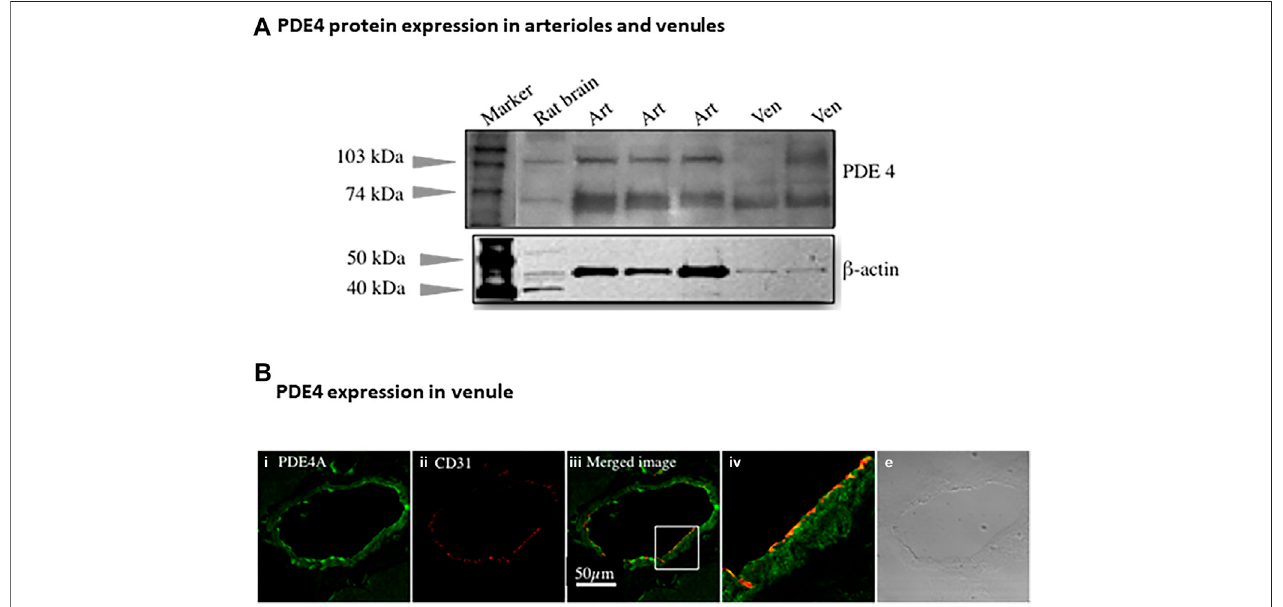
FIGURE 2 | PDE4 protein expression in skeletal muscles arterioles and venules. (A) The representative immunoblotting using non-selective PDE4 antibody shows PDE4proteinexpressedinarteriolesandvenulesisolatedfromratabdominalskeletalmuscles.Ratbrainwasusedasapositivecontrol.Theexpressionof β -actinprotein was used as a loading control for corresponding vessels. Art: arteriole; Ven: venule. (B) The representative immuno fl uorescence imaging was acquired using scanning confocalmicroscopy.ThesectionedratabdominalskeletalmusclewasstainedwithPDE4AprimaryandAlexa-488(greencolor)secondaryantibodies (i) aswellas CD31 (an endothelial marker) primary and Alexa-568 (red color) secondary antibody (ii) . The images of (i) and (ii) were superimposed (iii) , in which the yellow color indicatesco-localizationofPDE4AandCD31.Thesectioninthesmallboxofimagecwasenlarged (iv) ,showingtheco-localizationofPDE4AandCD31molecules.The transmitted light image (v) shows the venule of skeletal muscle tissue. The scale bar represents 50 µm for all the images except the image (iv) .